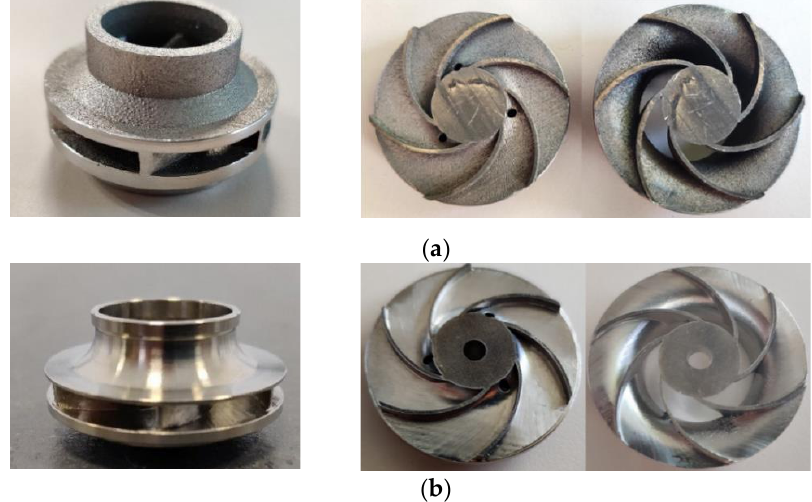
Figure 11. AM closed impeller: ( a ) before post-processing (no heat treatment applied); ( b ) after post-processing all surfaces.